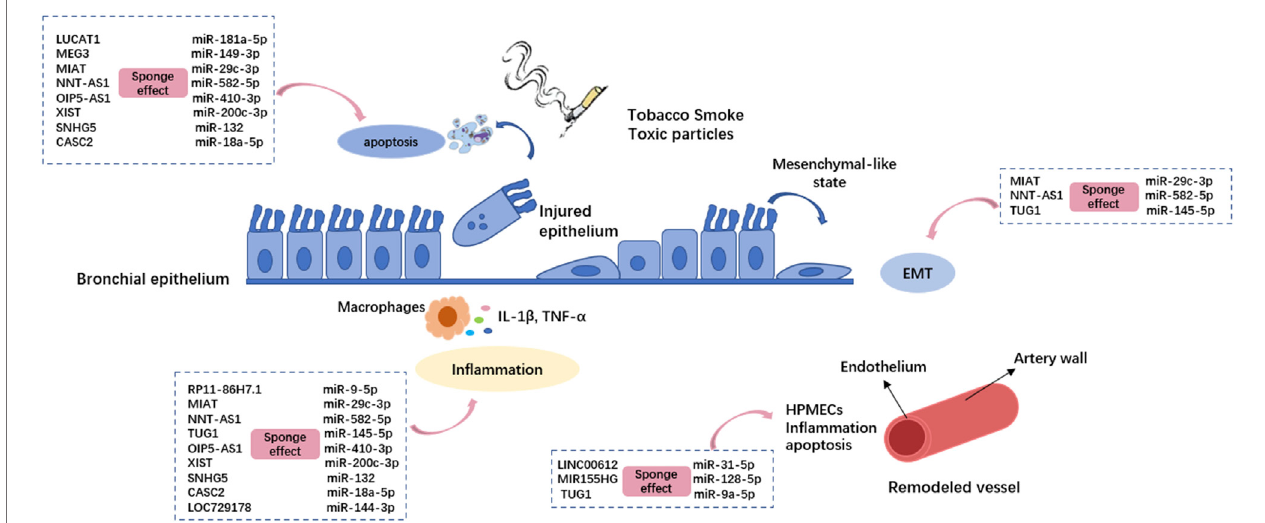
FIGURE2 | The lncRNA-miRNA crosstalkis involved inthe pathogenesis ofCOPD by regulating bronchial epithelial cells and pulmonary microvascular endothelial cells. Different lncRNAs regulate different miRNAs through the sponge effect, and then inhibit Mrna. The dotted boxes in the picture show typical lncRNA-miRNA interactions that function in COPD, which correspond to the cellular process they act on through pink arrows. HPMECs: Human pulmonary microvascular endothelial cells; EMT: epithelial – mesenchymal